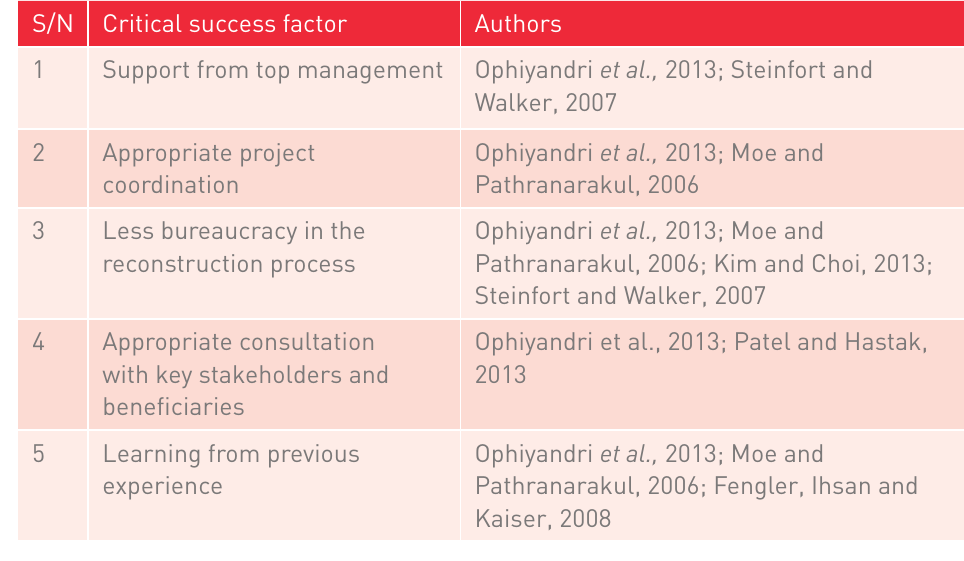
summary of Critical Success Factor (CSFs) for managing PDRPs